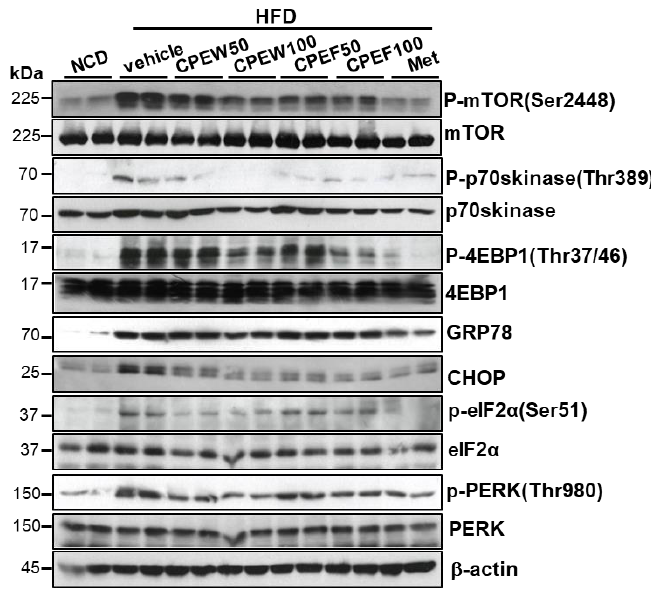
Figure 4. Citrus peel inhibits ER stress and mTORC1 in hyperlipidemic rats. Rats were placed on either an NCD or 60% HFD for eight weeks and were supplemented with ultra-pure water, metformin (100 mg / kg), or one of the indicated concentrations of citrus peel (50 and 100 mg / kg). Immunoblotting using antibodies against p-mTOR, mTOR, p-p70S6K, p70S6K, p-4EBP-1, 4EBP-1, GRP78, CHOP, p-PERK, PERK, p-eIF2 α , eIF2 α , and β -actin. CPEW, citrus peel extract hot-air dry; CPEF, citrus peel extract freeze-drying; HFD, high-fat diet; NCD, normal calorie diet.